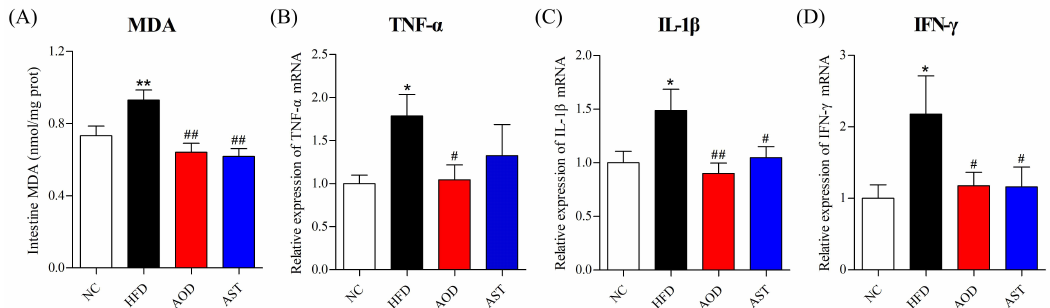
Figure 3. AOD improved the malondialdehyde (MDA) level and the expression levels of pro- inflammatory cytokines in the jejunum. ( A ) MDA level. ( B – D ) mRNA expression levels of tumor necrosis factor (TNF)- α , interleukin 1 β (IL-1 β ), and interferon- γ (IFN- γ ). NC: normal control diet; HFD: high-fat and high-sucrose diet; AOD: high-fat and high-sucrose diet supplemented with astaxanthin n -octanoic acid diester (50 mg / kg body weight) for 8 weeks; AST: high-fat and high-sucrose diet supplemented with free astaxanthin (50 mg / kg body weight) for 8 weeks. The values are presented as mean ± SEM, n = 10. * p < 0.05, ** p < 0.01 vs. NC, and # p < 0.05, ## p < 0.01 vs. HFD group.